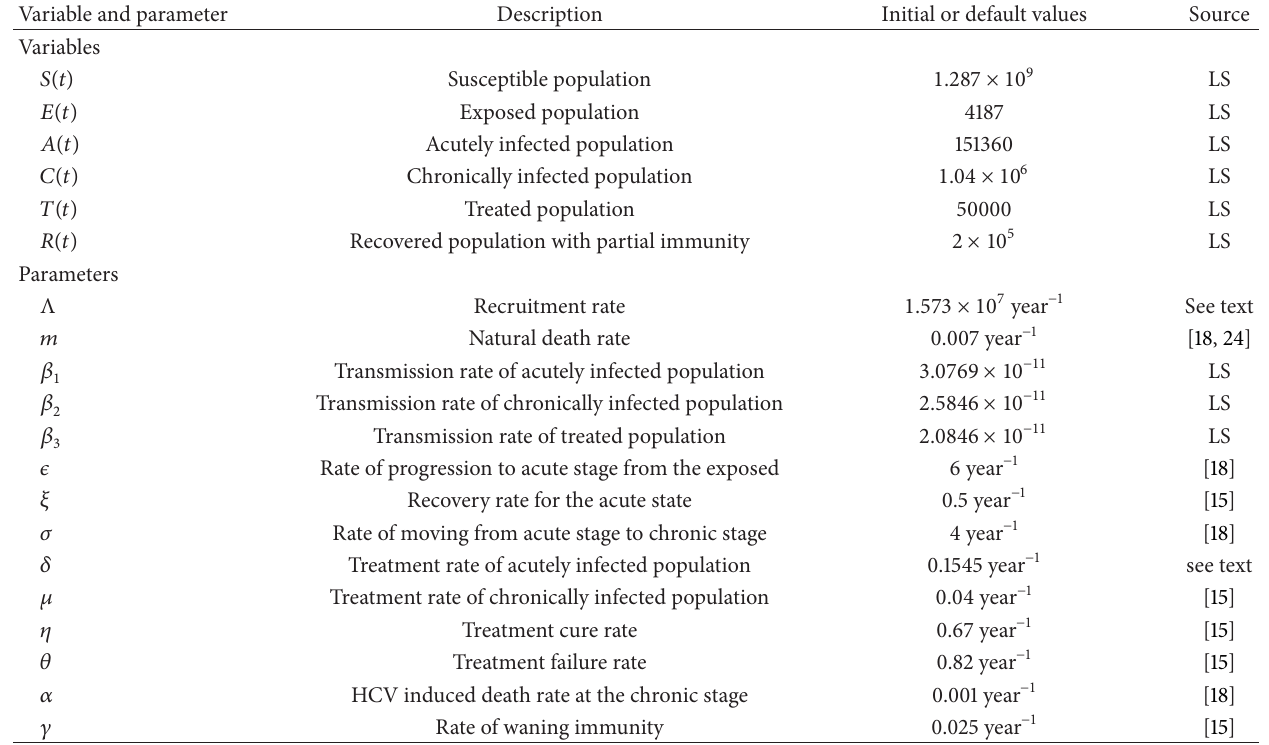
Table 1: Parameters and initial data chosen for the simulation.